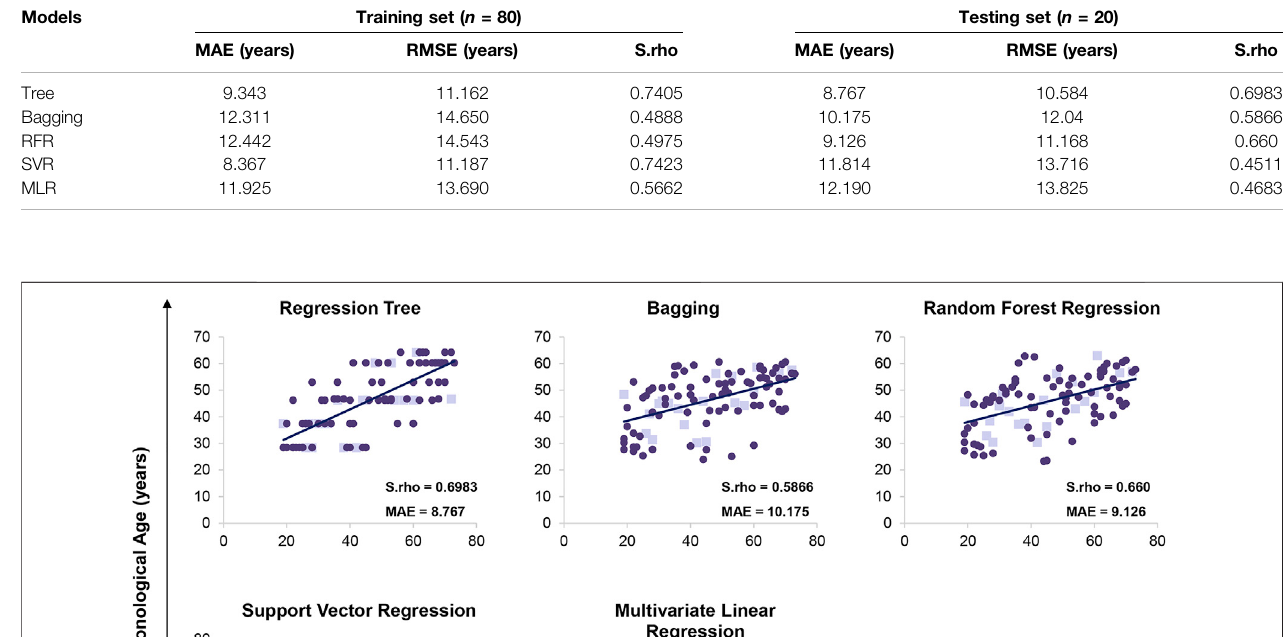
Frontiers in Genetics |